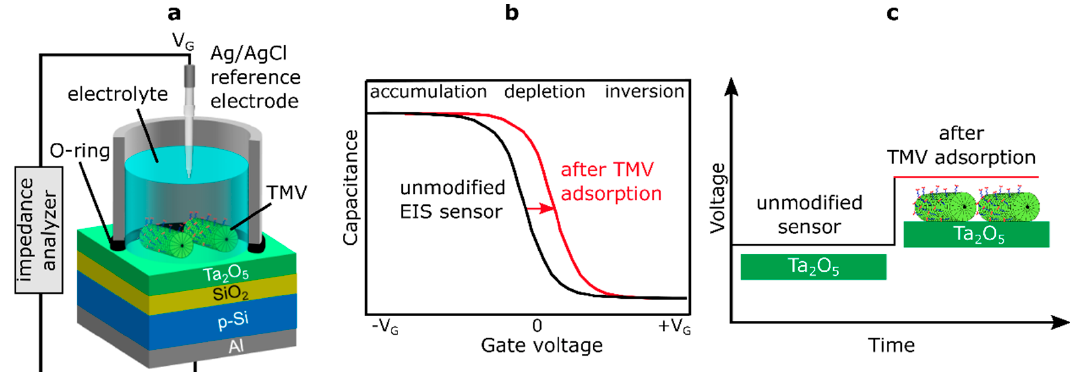
Figure 3. ( a ) Measurement setup of the TMV-modified EIS sensor chip, ( b ) typical shape of a high-frequency C–V curve for a p-type EIS sensor with characteristic regions of accumulation, depletion and inversion, and ( c ) ConCap response of the bare (unmodified) EIS sensor and after TMV adsorption.